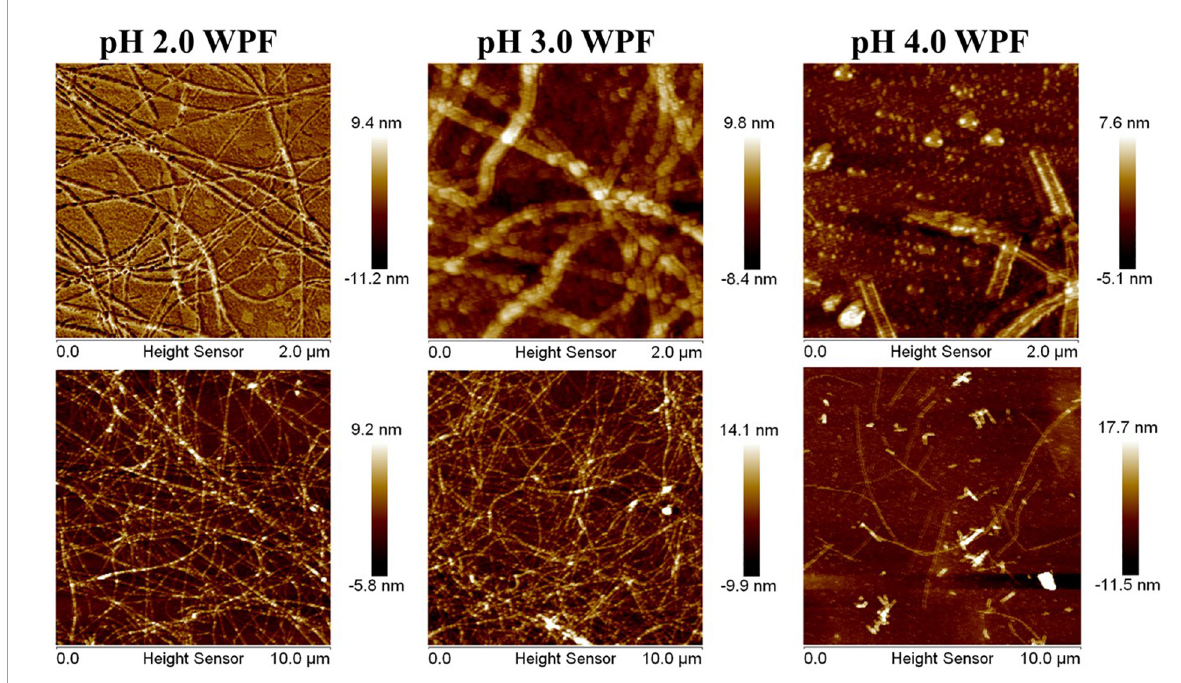
FIGURE1 Atomic force microscope images of whey protein fibrils (WPF) at pH 2.0–4.0.